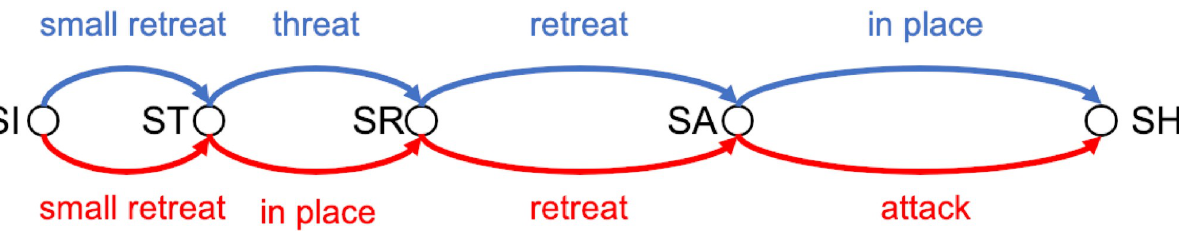
PLOS ONE | https://doi.org/10.1371/journal.pone.0261888 December30,